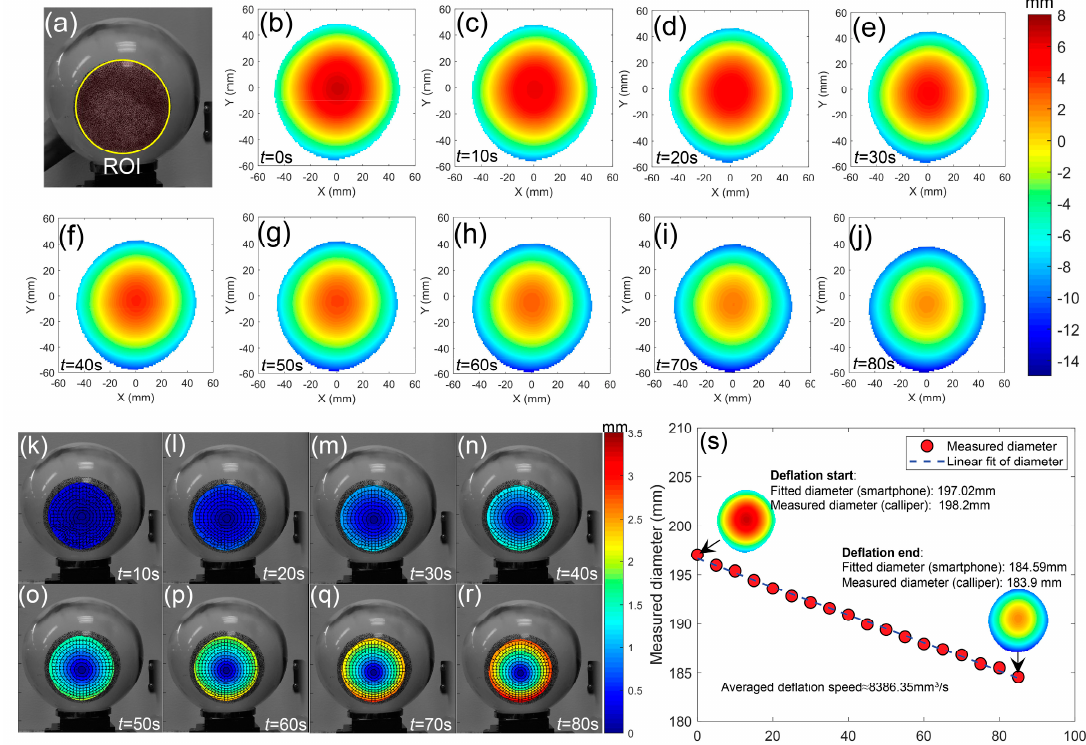
Figure 14. ( a ) The region of interest during the calculation and ( b – j ) the reconstructed 3D shapes on the ball surface at different time steps, ( k – r ) radial displacement vector superimposed on the radial contours on the ball surface at different time steps, ( s ) the fitted diameters as a function of time.